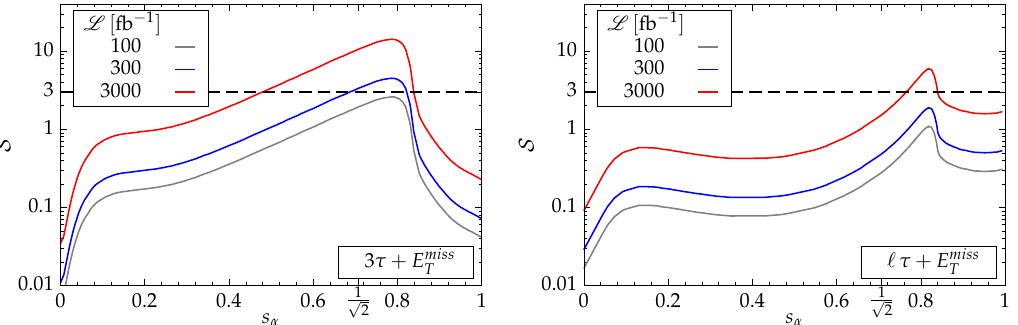
Figure 11 . The variation of the statistical significance, S with the mixing parameter s α for fixed values of other free parameters [ ( m φ , m p S = 2 [( S + B ) ln(1 + S/B ) − S ] , where S and B respectively are the number of expected signal and background events at a particular integrated luminosity L